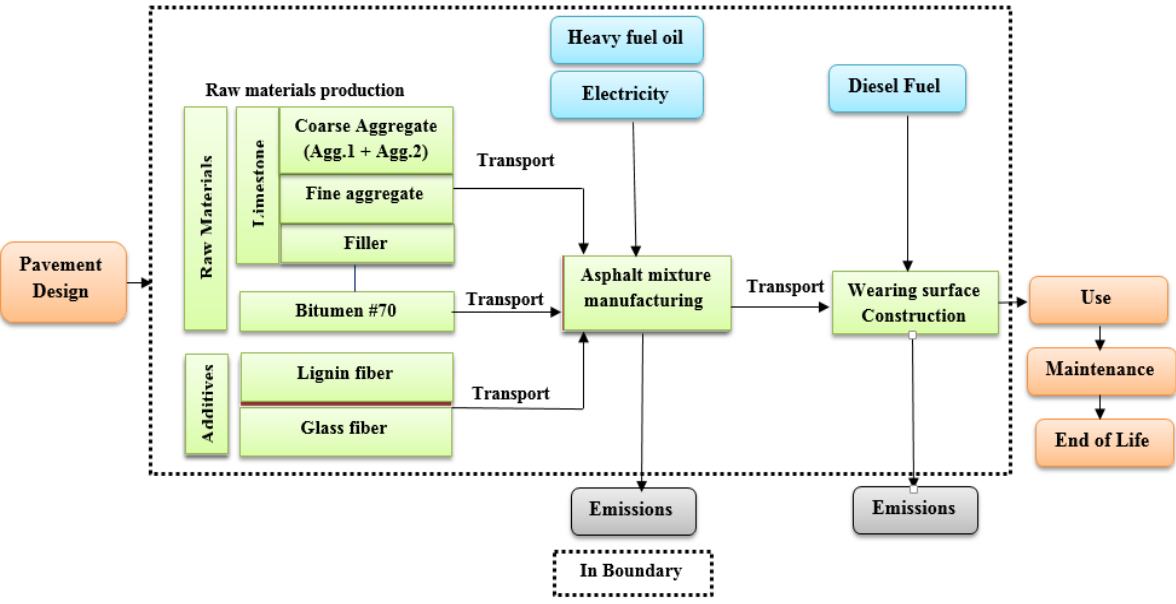
Figure 2. The system boundaries of selected pavement life cycle phases.